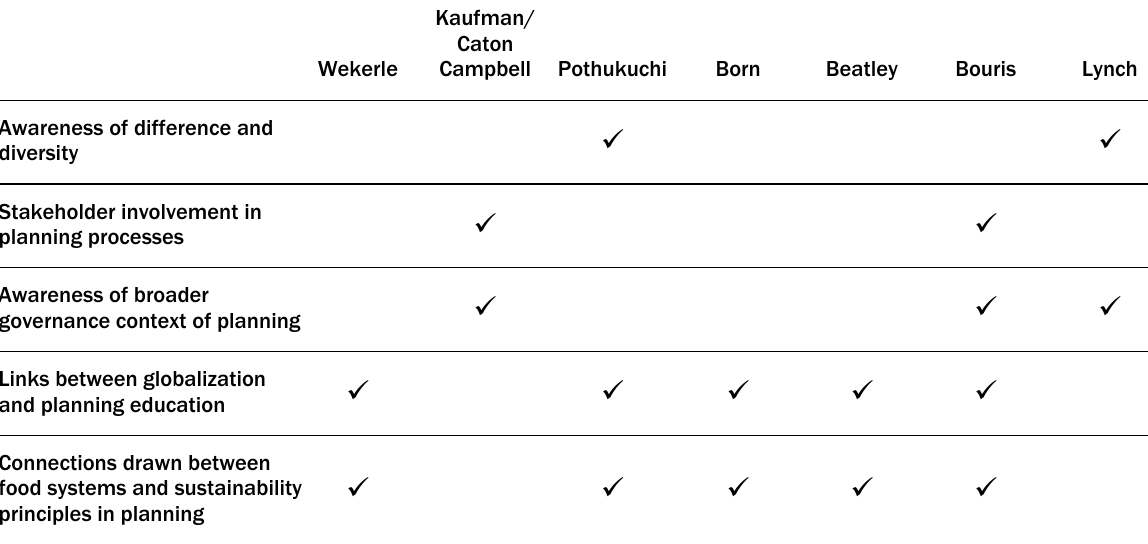
Table 1. Themes Emerging from Contributors’ First-hand Narratives: Connections Between Teaching About Food Systems and Related